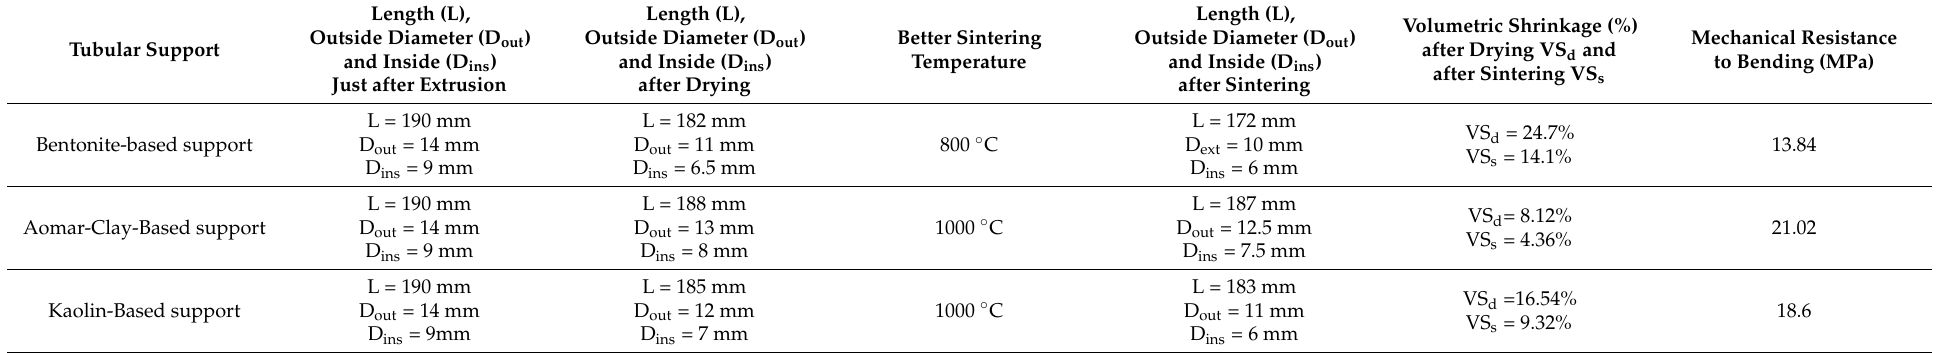
Table 3. Physical-mechanical characteristics of the tubular supports obtained from each type of